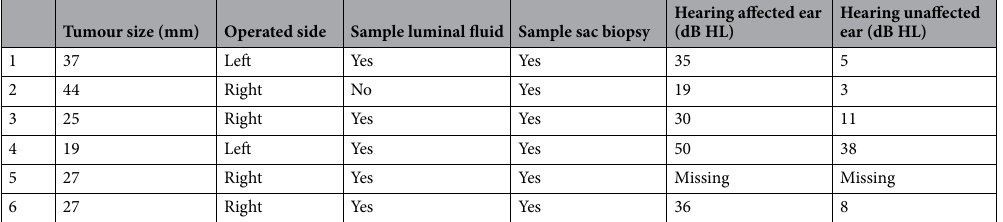
Table 2. Patients’